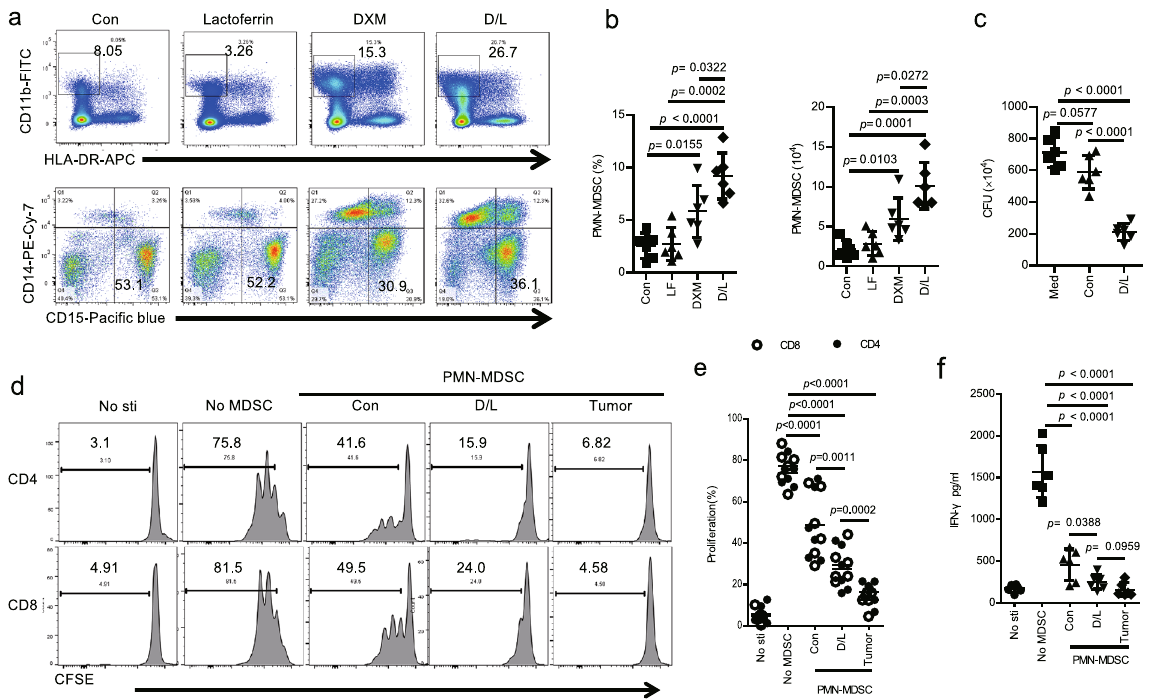
Fig. 2 DXM- and lactoferrin-induced human PMN-MDSC in vitro from human peripheral blood mononuclear cells (PBMCs). a , b PBMCs from an adult healthy donor were treated with lactoferrin, DXM, combination of DXM and lactoferrin (D/L), or PBS vehicle (Con) in the presence of GM-CSF and IL-6 for 3 d. PMN-MDSCs were analyzed using a fl ow cytometer. a Typical example of fl ow cytometric analysis. b Absolute numbers and proportion ( n = 6 biologically independent samples). c Antibacterial activity of Con PMN-MDSCs and D/L PMN-MDSCs isolated from PBS- or D/L-treated PBMCs against E. coli ( n = 6 biologically independent samples). d – f Suppressive activity of Con PMN-MDSCs and D/L PMN-MDSCs against proliferation of T cells from PBMC stimulated with anti-CD3/anti-CD28 were tested by CFSE. Non-stimulated T cells (No-sti), stimulated T cells without PMN-MDSC (No-MDSC), and tumor PMN-MDSCs from hepatocellular carcinoma patients were used as controls. d Typical example of fl ow cytometric analysis. e Statistical analysis. f IFN- γ level (in media) analyzed by ELISA ( n = 6 biologically independent samples). Error bars displayed the mean and standard